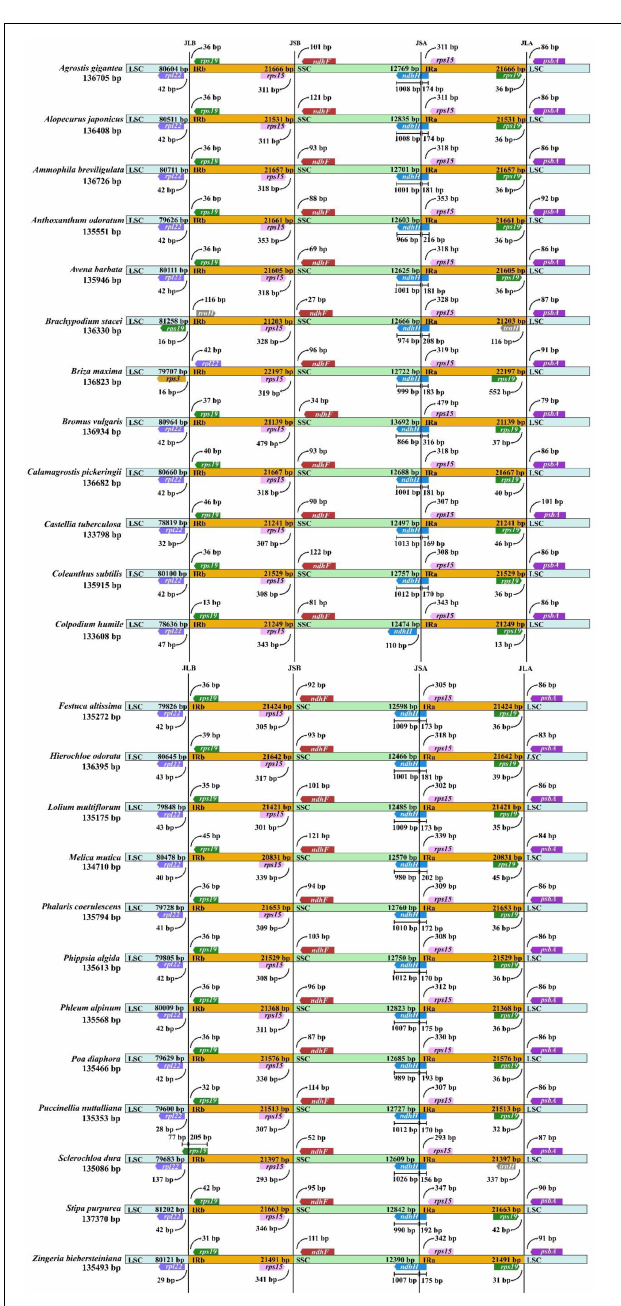
FIGURE 3 | A plot of comparative analysis of the boundary features of the 24 Poaceae species. The comparative regions are the boundaries of large single copy (LSC), small single copy (SSC) and inverted repeat (IR)